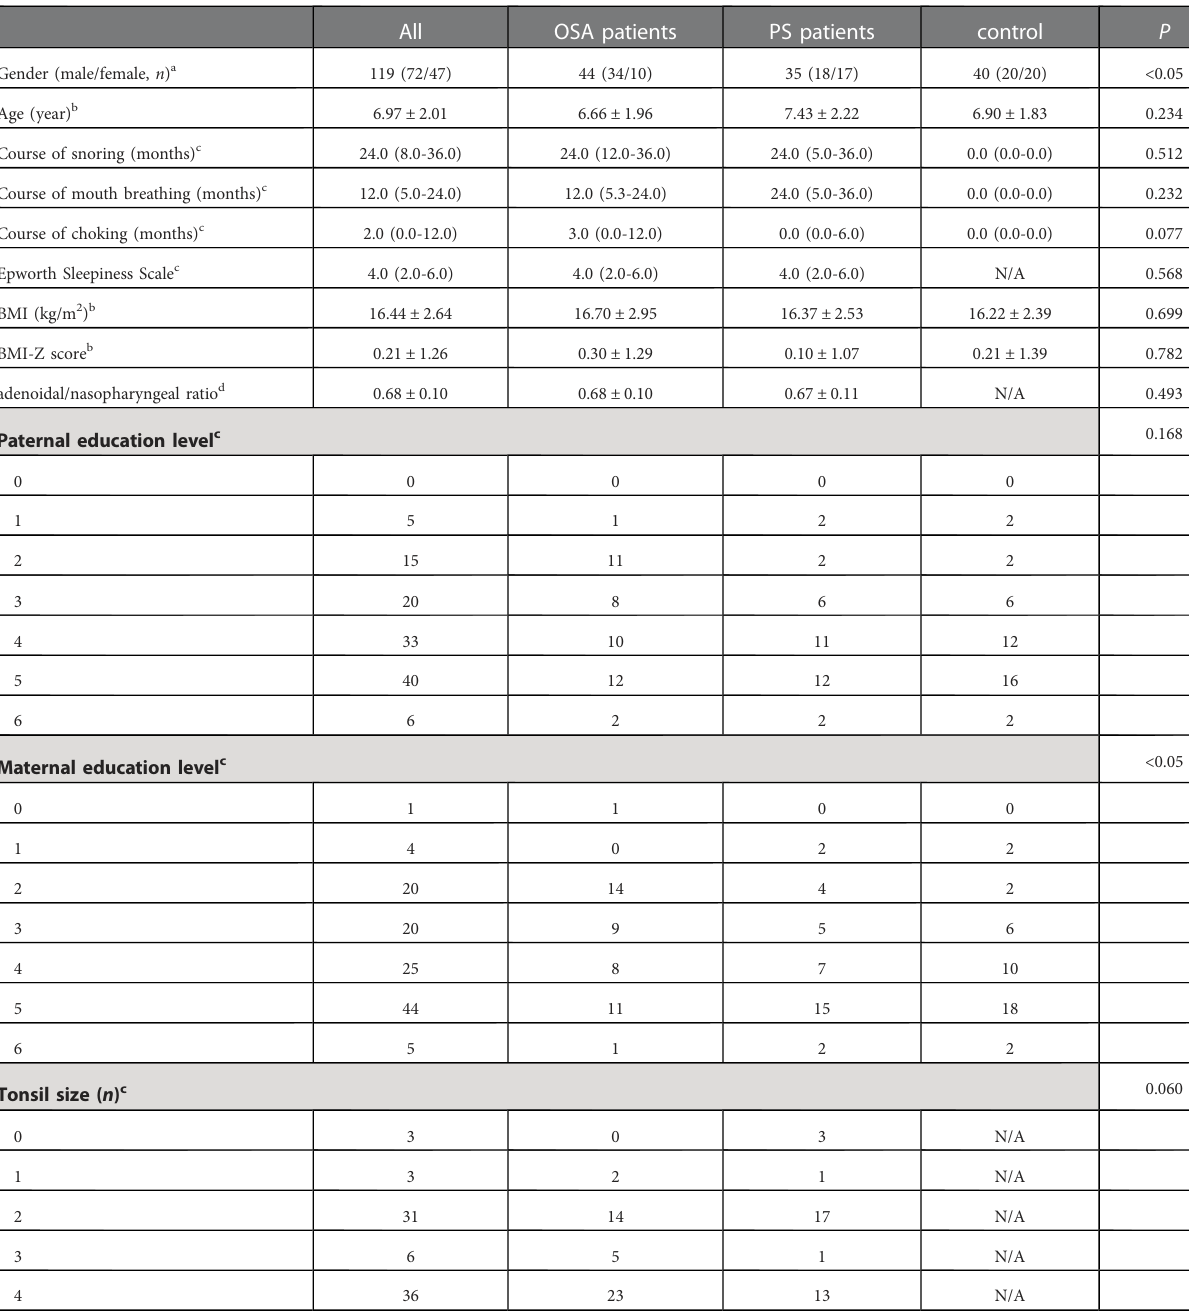
TABLE 1 Comparisons of demographic and clinical characteristics among three